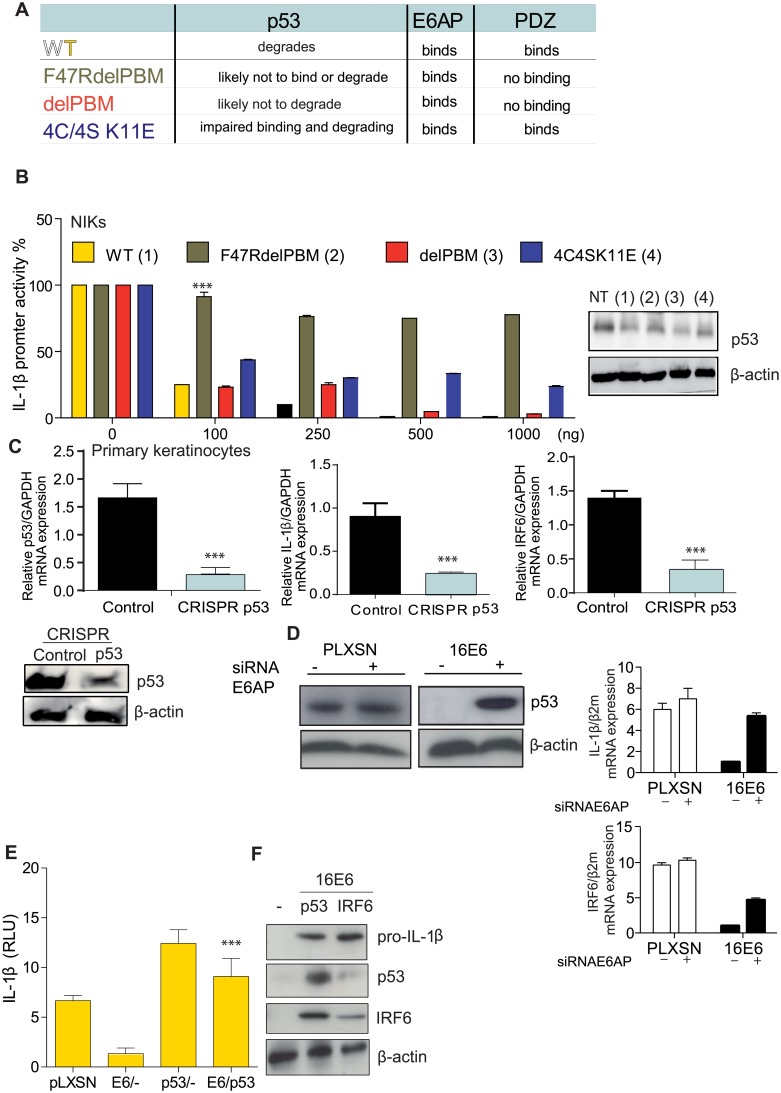
Loss of p53 inhibition by 16E6 restores IRF6 activity.(A) Table defining the 16E6 mutations that alter p53, E6AP or PDZ binding sites. (B) NIKs were co-transfected with IL-1β promoter luciferase construct along with the HPV16E6 WT and mutated constructs at the indicated concentration. n = 5. (C) Human primary keratinocytes were transfected with cas9/sgRNA for p53 or control and 36h later cells were examined for mRNA levels for p53, IL-1β or IRF6. n = 4. (D) siRNAE6AP (+) or siRNA scramble control (-) was transfected into PLXSN or 16E6 transduced human keratinocytes for 48 h, cells were harvested for protein and RNA. Western blot analysis for p53 and β-actin. Left top, RT-qPCR for IL-1β and, left below IRF6. n = 3, (E) NIKs were co-transfected with the IL-1β promoter and pLXSN, E6, p53 or E6 with p53. Luciferase activity was measured 48 h post infection. n = 4. (F) 16E6 transduced primary keratinocytes were transfected with vector control (-), p53 or IRF6 expression vectors. Twenty-four hours later cells were harvested and pro-IL-1β, p53 or IRF6 levels were examined by immunoblotting. n = 4. Data are representative of n independent experiments performed in triplicate. Shown are the mean ± SEM with ***, P < 0.0001, based on an one or two way (applicable to > 2 conditions) ANOVA test. For immunoblotting data, 1 out of 4 experiments is shown.